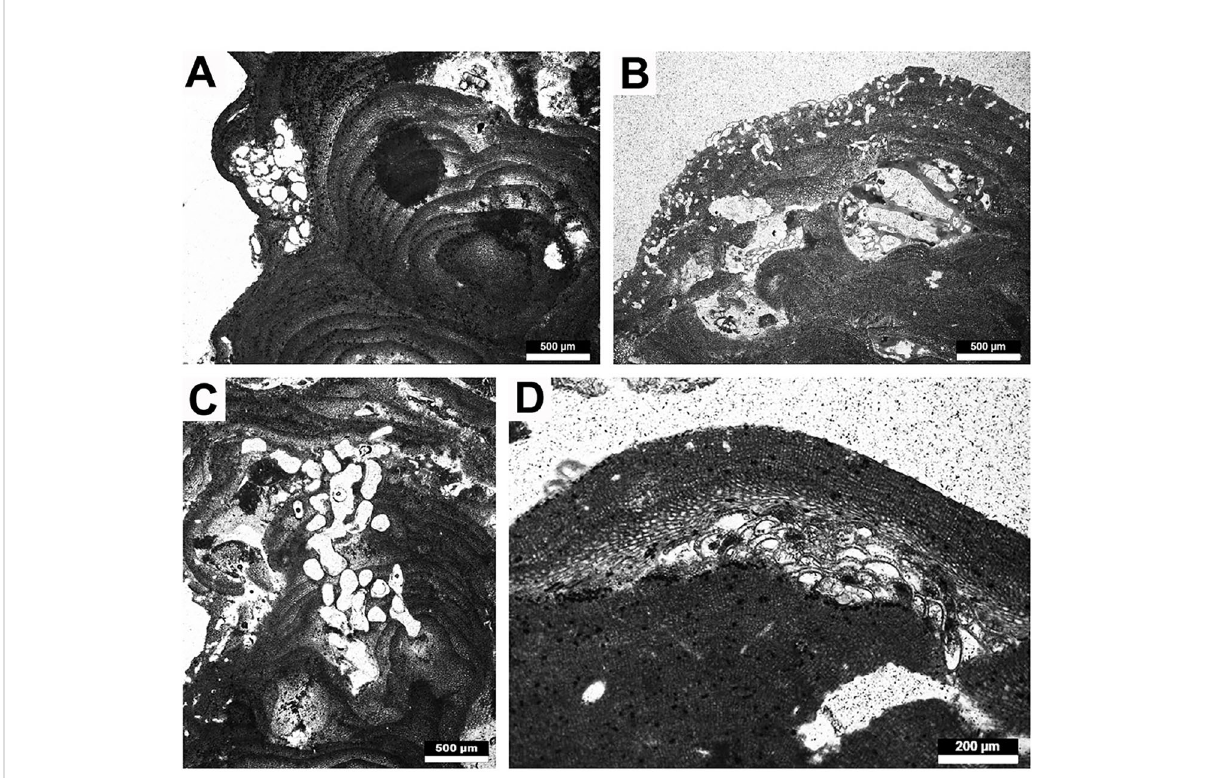
FIGURE 5 Borings and encrusters present on the Fuerteventura rhodoliths. (A) Encrusting foraminifer? interspersed in the coralline thalli, (B) small-size borings at the coralline thallus extremity and other encrusters, (C) medium-size borings throughout a coralline thallus, (D) bryozoan? in between the coralline